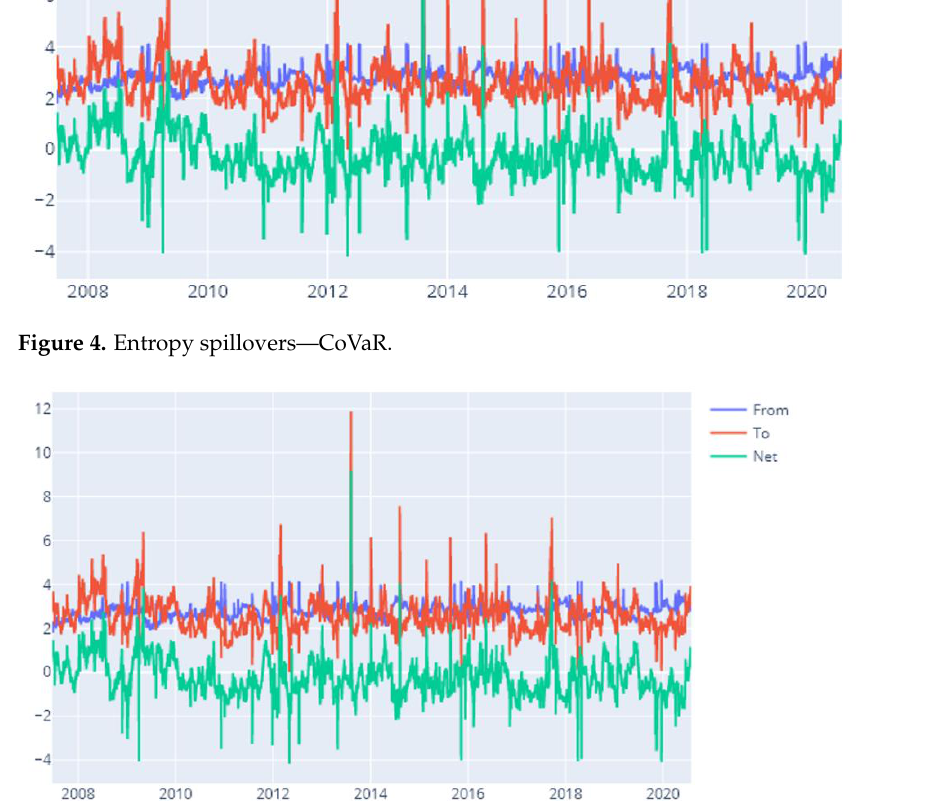
Figure 4. Entropy spillovers — CoVaR.